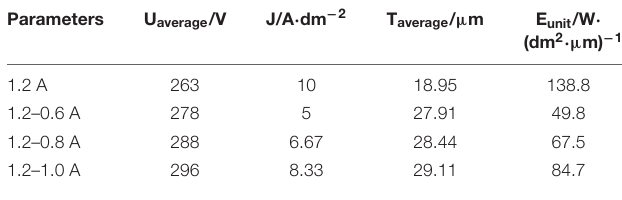
TABLE 3 | Unit energy consumption of different current modes in the final